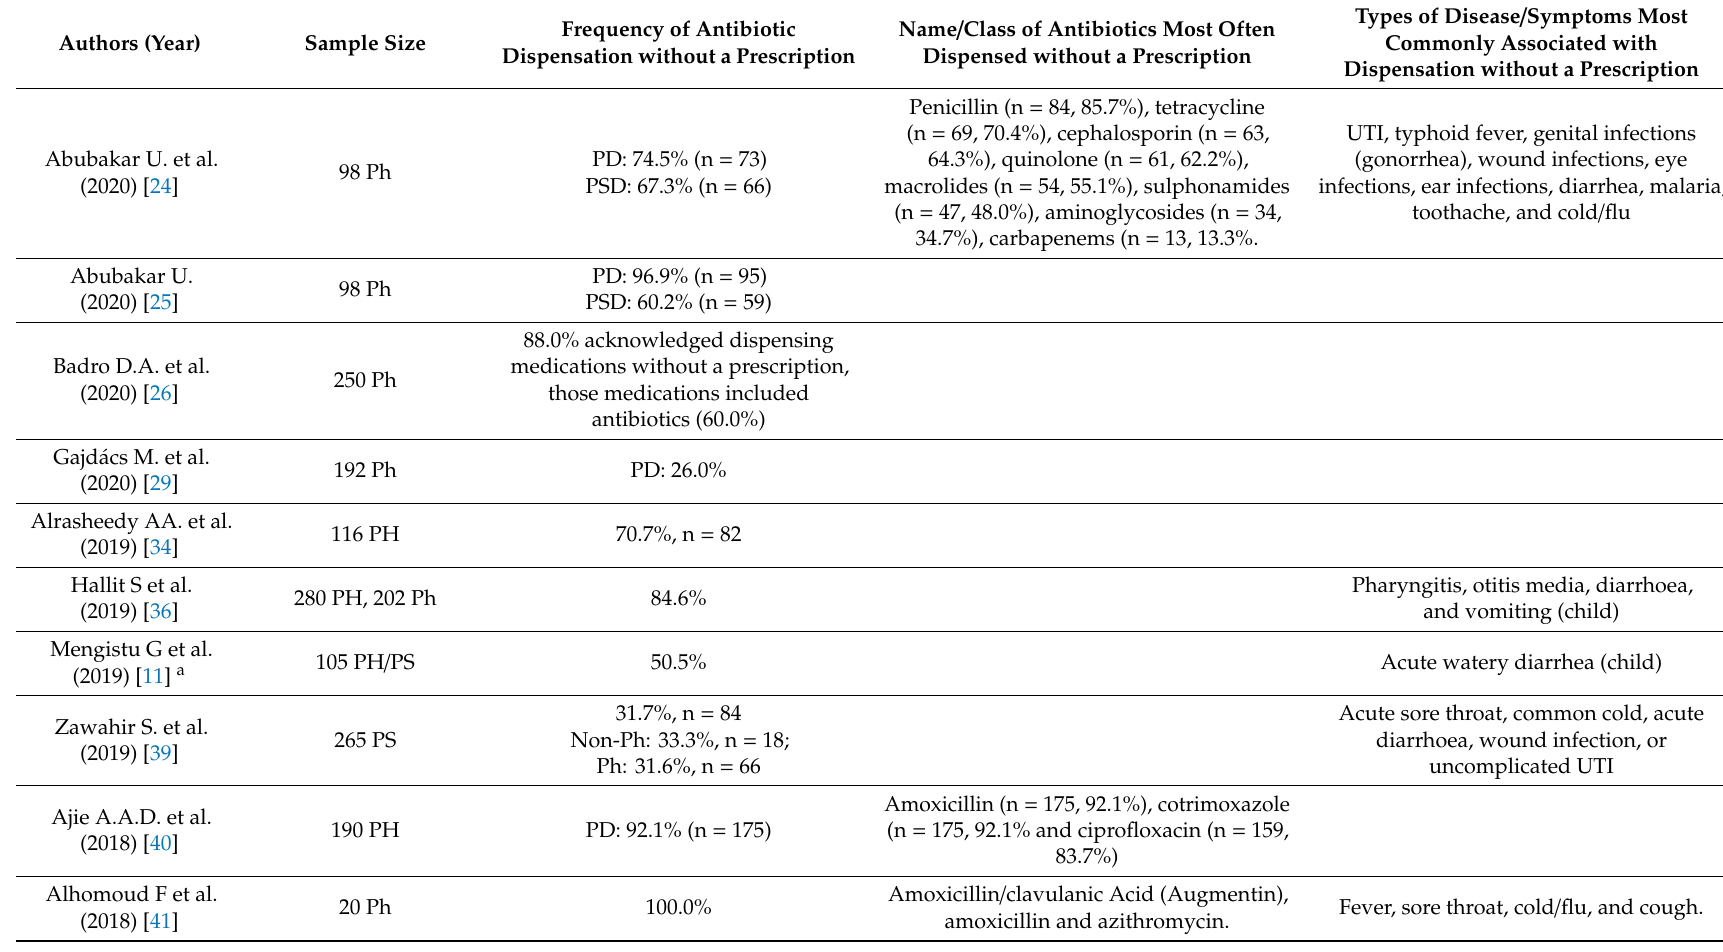
Table 3. Study Outcomes—articles that used the Pharmacy interviews /